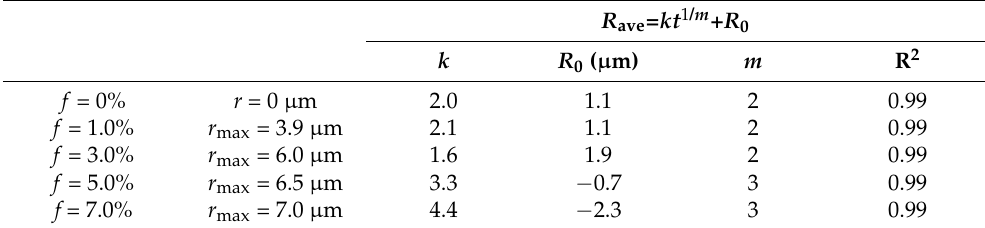
Table 4. Variation of parameters in the grain growth index equation with second-phase particle